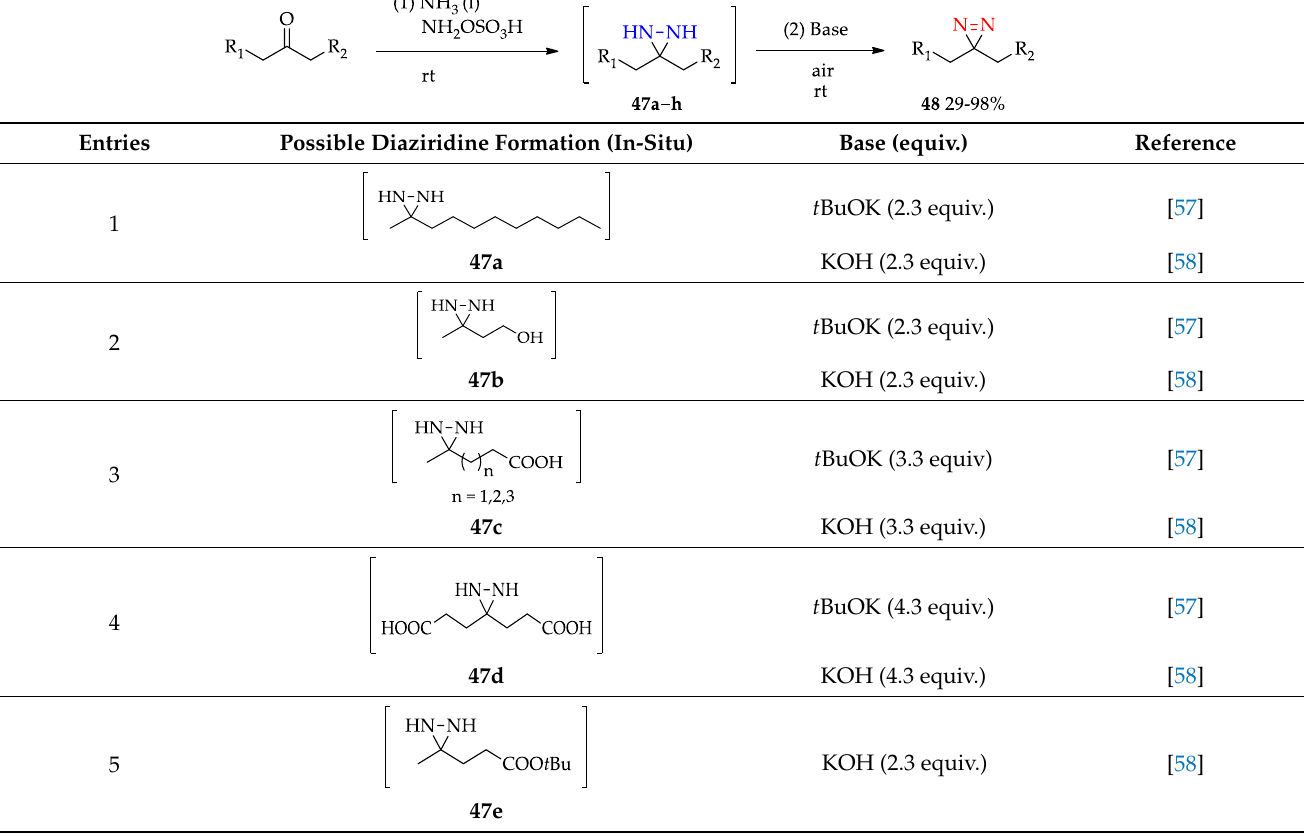
Table 2. Diaziridine in-situ formation in one-pot aliphatic 3 H- diazirine 48 syntheses.